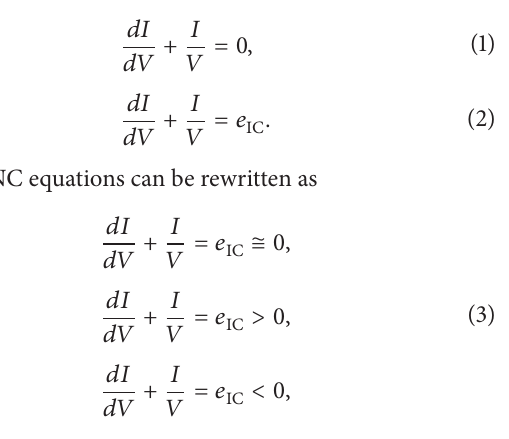
of solar PV array if the entire array does not receive uniform solar